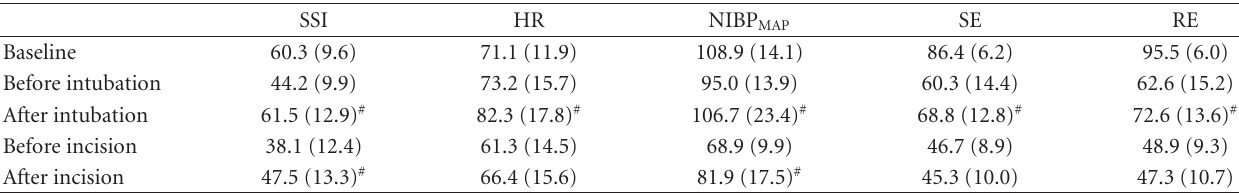
Table 2: Mean surgical stress index (SSI ± SD), heart rate (HR ± SD), noninvasive mean arterial pressure (NIBP MAP ± SD), spectral entropy (SE ± SD), and response entropy (RE ± SD) values at di ff erent measuring